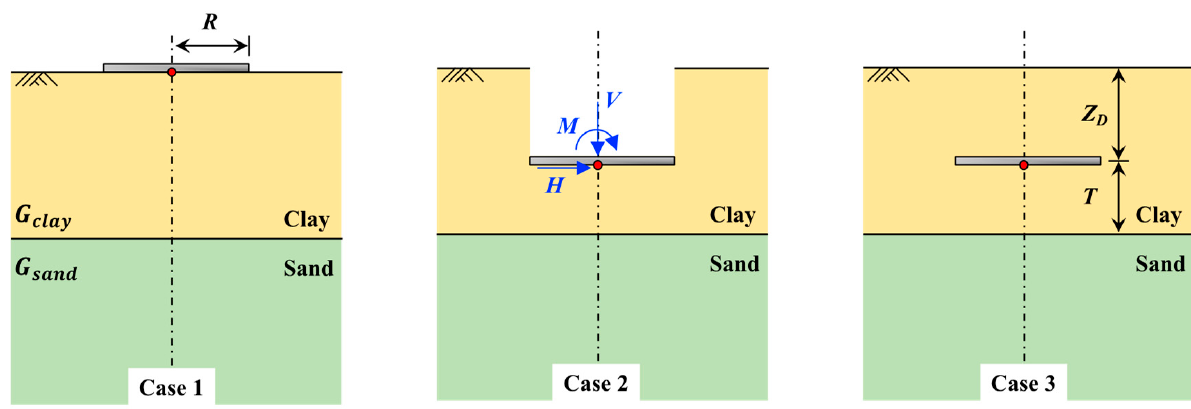
Figure 2. Cases of three embedment conditions. Table 1. The simulation programs in [5] and this study.